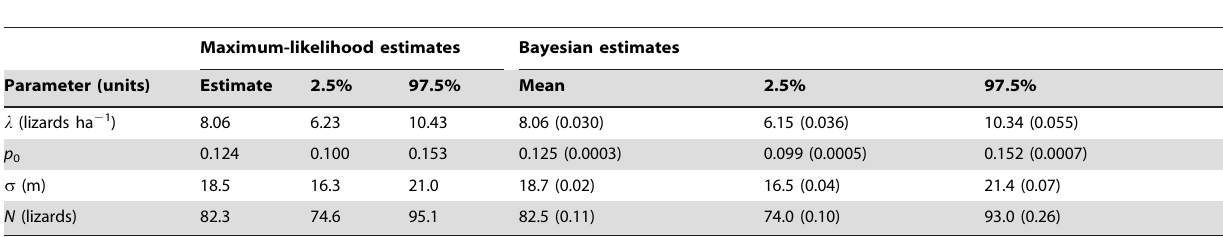
Table 3. Estimates of parameters of model fitted to locations of lizards recaptured during area-search surveys.